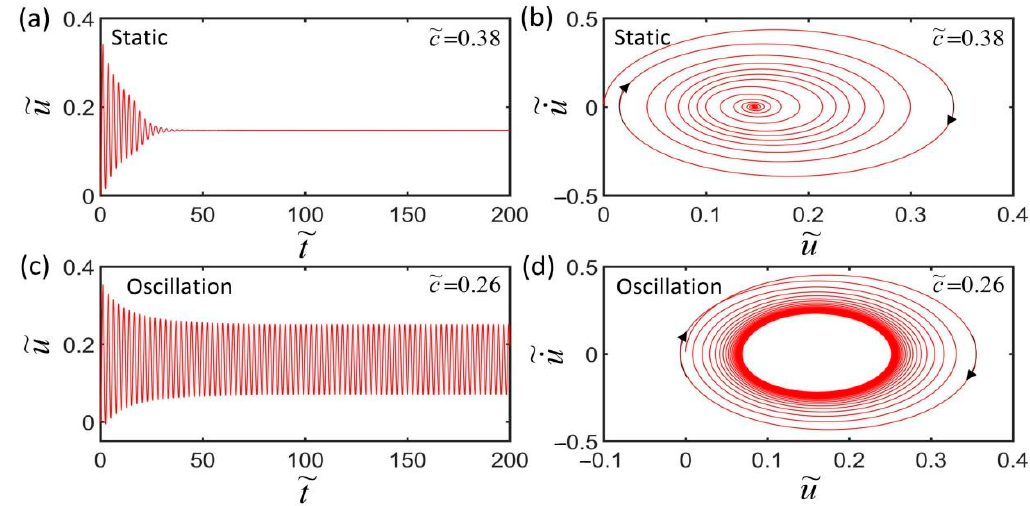
38.0~ = c ); ( c , d ) oscil-